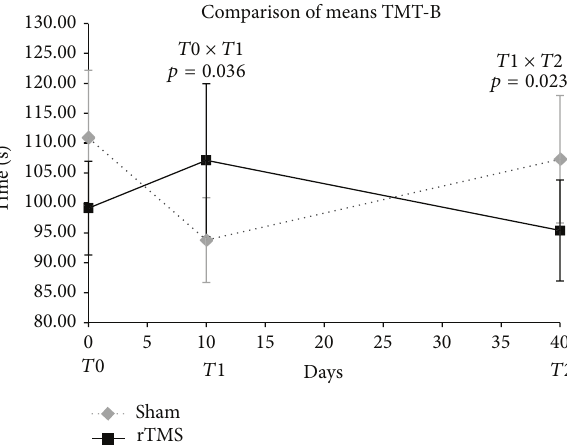
Figure 5: Comparison of Trail Making Test B means scores in T0, T1, and T2. Two-way ANOVA for repeated measures. Timing of procedures: T0: baseline cognitive assessment and 1st rTMS; T1: 10th rTMS session and 2nd cognitive assessment; T2: 30 days after T1 and 3rd cognitive assessment. Mann-Whitney-Wilcoxon test for comparison of rTMS versus sham basal means, 𝑝 = 0.986